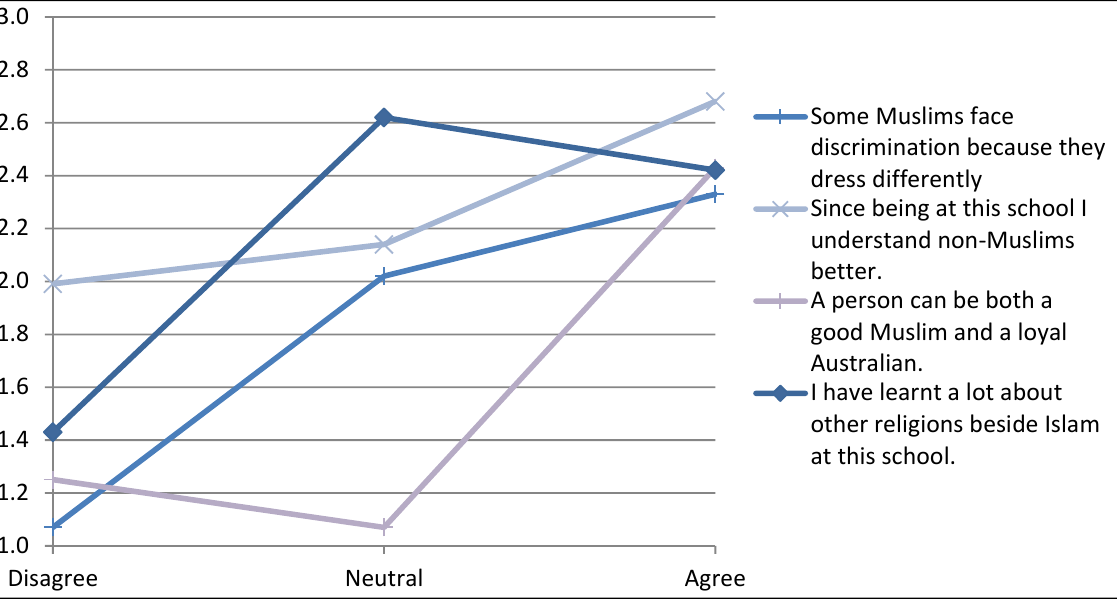
Figure 3. Tabulation of two variables showing Level of Knowledge and responses to statements measuring attitudes and